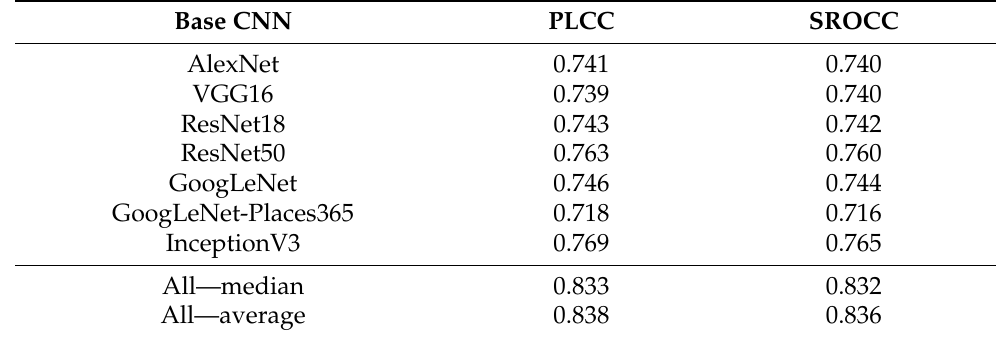
Table 7. Performance of different base architectures and decision fusion methods using SWGAP layers for feature extraction and SVRs with Gaussian kernel function for regression. Median PLCC and SROCC were measured over 1000 random train–test